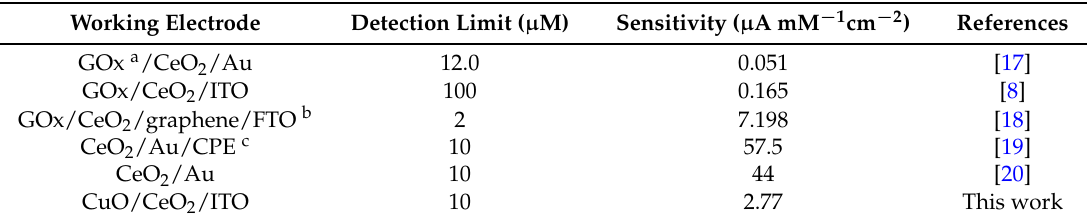
Figure 7. Amperometric response of CuO/CeO 2 /ITO electrode measured at 0.4 V in 0.1 M PB solution with successive addition of 10 mM glucose. Inset is the plot of current response with glucose concentration. Table 1. Comparison of performance obtained from different cerium oxide (CeO 2 )-based glucose biosensors. Working Electrode